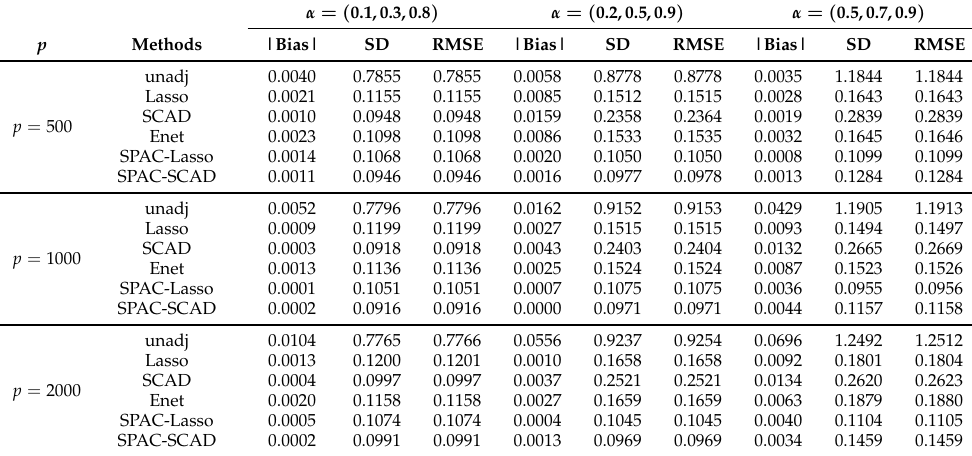
Table 1. Finite sample performance of the ATE